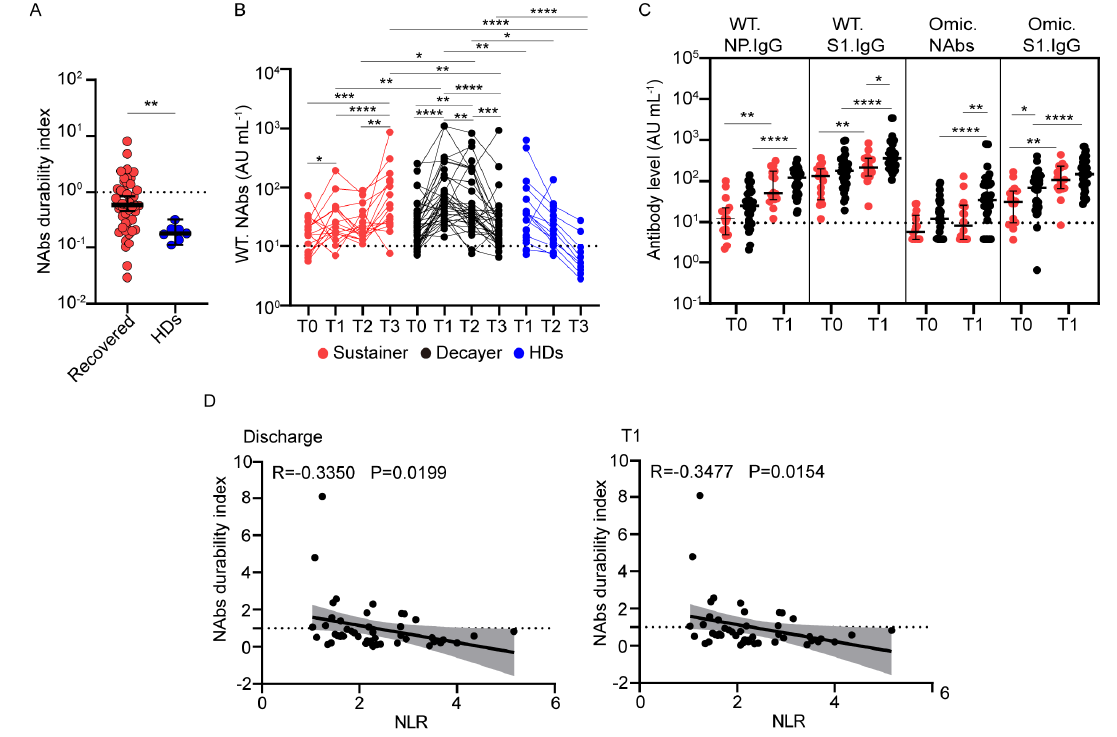
Figure 4. Association of clinical factors with wild-type neutralizing antibody duration after vac- cination. ( A ) Dot plot shows the ranges of NAbs durability index for individuals with previous SARS-CoV-2 infection (red, n = 49) and healthy donors (blue, n = 7). ( B ) Wild-type NAb levels in the Sustainer group (red, n = 16), Decayer group (black, n = 33), and healthy donors (blue, n = 7) after vaccination. ( C ) Dot plot showing the antibody levels in the Sustainer group (red, n = 16) and Decayer group (black, n = 33) at 12 months after infection (T0) and 3 months post-vaccination (T1). ( D ) Spearman rank correlation was used to analyze the NAbs durability index and the neutrophil-to- lymphocyte ratio at discharge (left) and 3 months after vaccination (T1) (right). The linear fitting was performed, and gray indicates 95% confidence intervals. Statistics were calculated using Wilcoxon’s signed ‐ rank test for paired groups and Mann–Whitney U test for unpaired groups: * p < 0.05; ** p < 0.01; *** p < 0.001; **** p < 0.0001. NAbs, neutralizing antibodies; WT, wild ‐ type strain; Omic, Omi ‐ cron; NLR, neutrophil ‐ to ‐ lymphocyte ratio. Table 2. Effect analysis of age, hospital days, sex, and disease severity on NAbs durability index in SARS ‐ CoV ‐ 2 Recovered individuals.